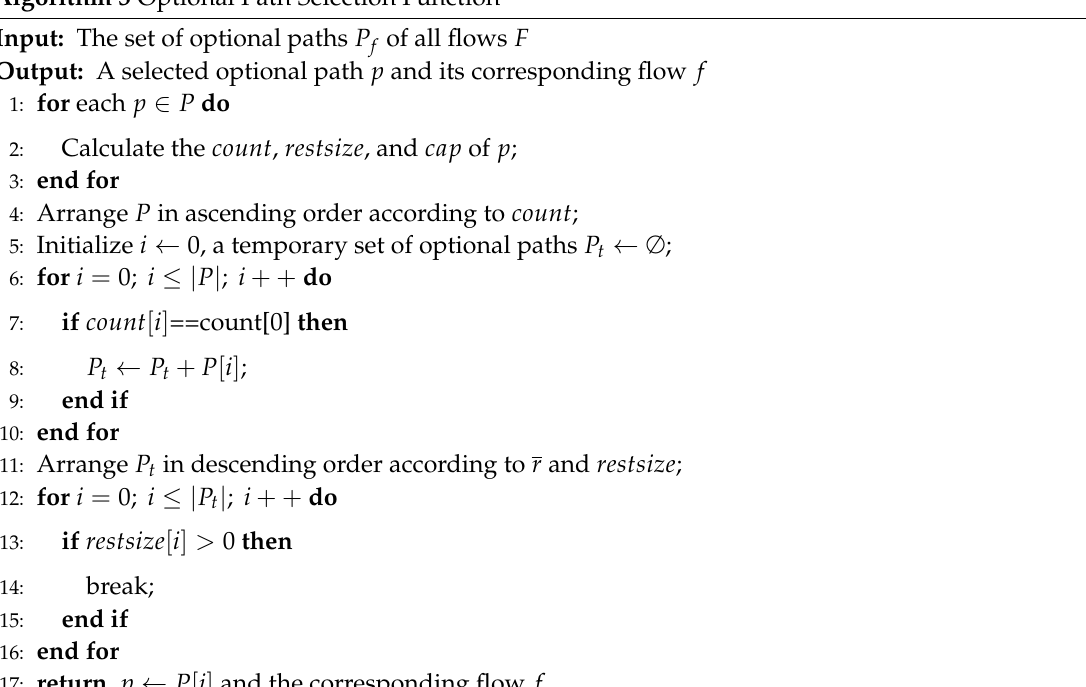
Algorithm 3 Optional Path Selection